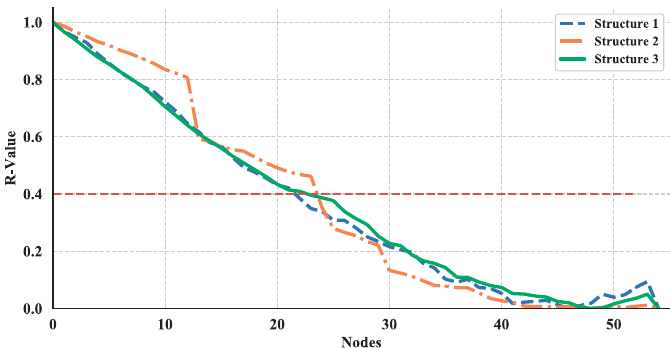
Figure 27. Robustness illustration, where nodes removed from structure layer of network.